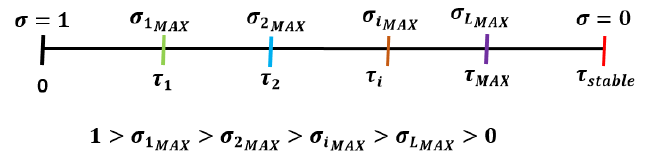
Figure 4. Relation between the network delay and the σ